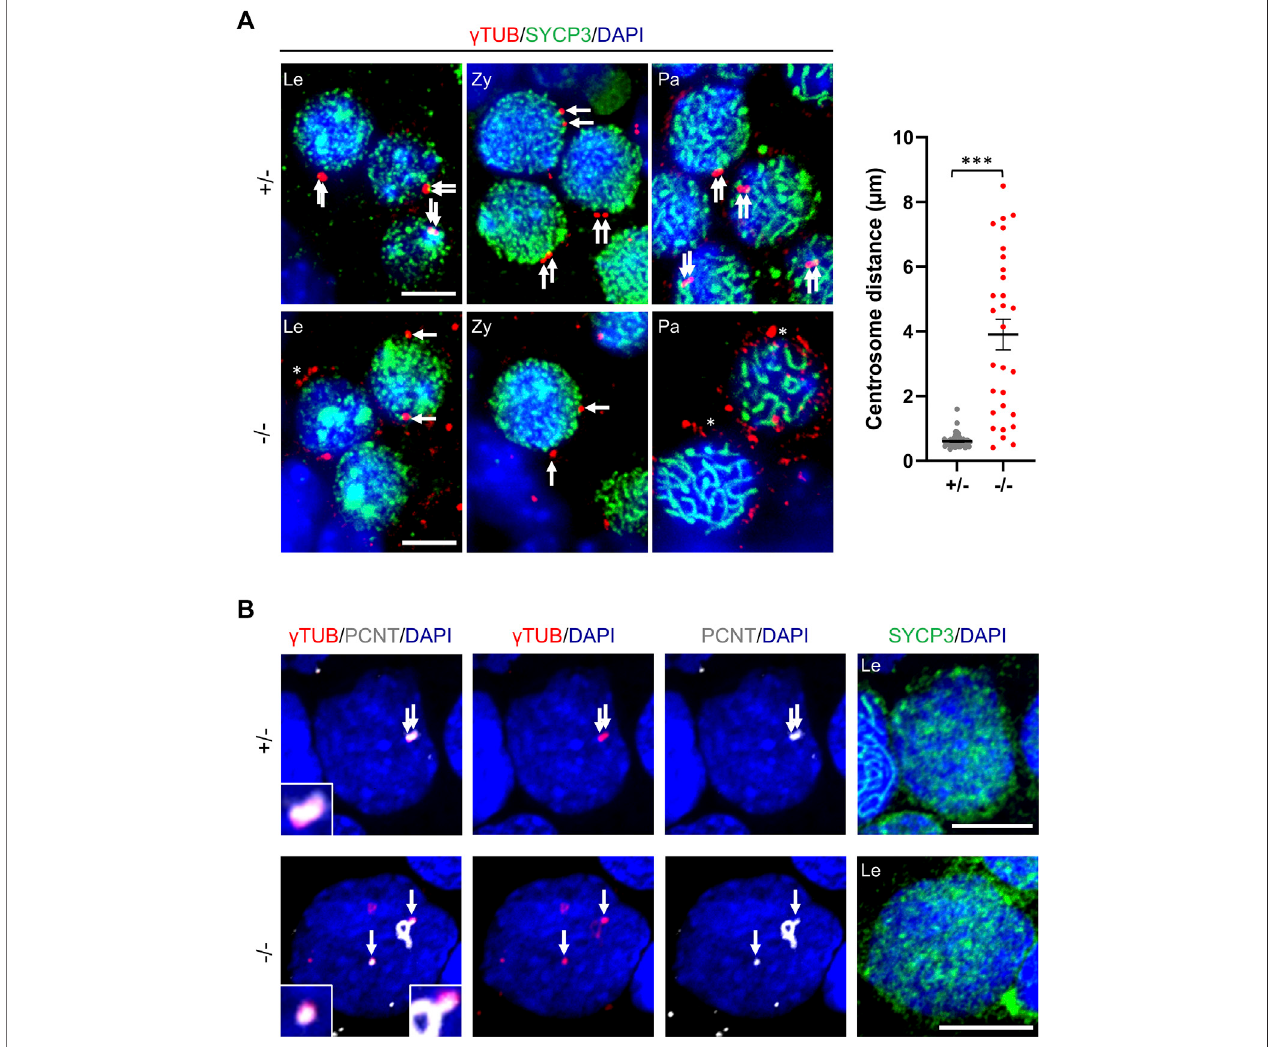
FIGURE 7 | Centrosome cohesion is impaired in the absence of Cep250. (A) Immuno fl uorescence analysis of γ -tubulin (red) and SYCP3 (green) in the post-natal testis sections (15 dpp). DNA is stained with DAPI. Arrows indicate γ -tubulin pericentromeric material. Asterisks indicate fragmentation of γ -tubulin. Le: Leptotene; Zy: Zygotene;Pa:Pachytene.Scalebar:5 µm.Quanti fi cationofthe γ -tubulinfocidistanceisshownintherightpanel.+/ − n (cid:1) 51 − / − n (cid:1) 29;mean ± SEM.*** p < 0.001 t -test. (B) Immuno fl uorescence analysis of γ -tubulin (red), pericentrin (PCNT, gray) and SYCP3 (green) in post-natal testis cells. Magni fi cation of γ -tubulin and pericentrin stained centrosomes are shown. Le: Leptotene. Scale bar: 10